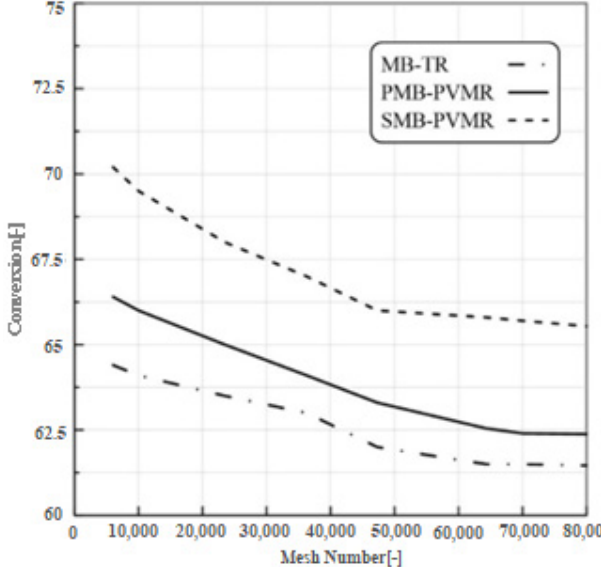
Figure 2. Effect of mesh number on the calculated LA conversion by CFD model (ET/LA: 1, feed flow rate 10 mm 3 /s, reaction temperature 333 K, and W = 8.6 g).